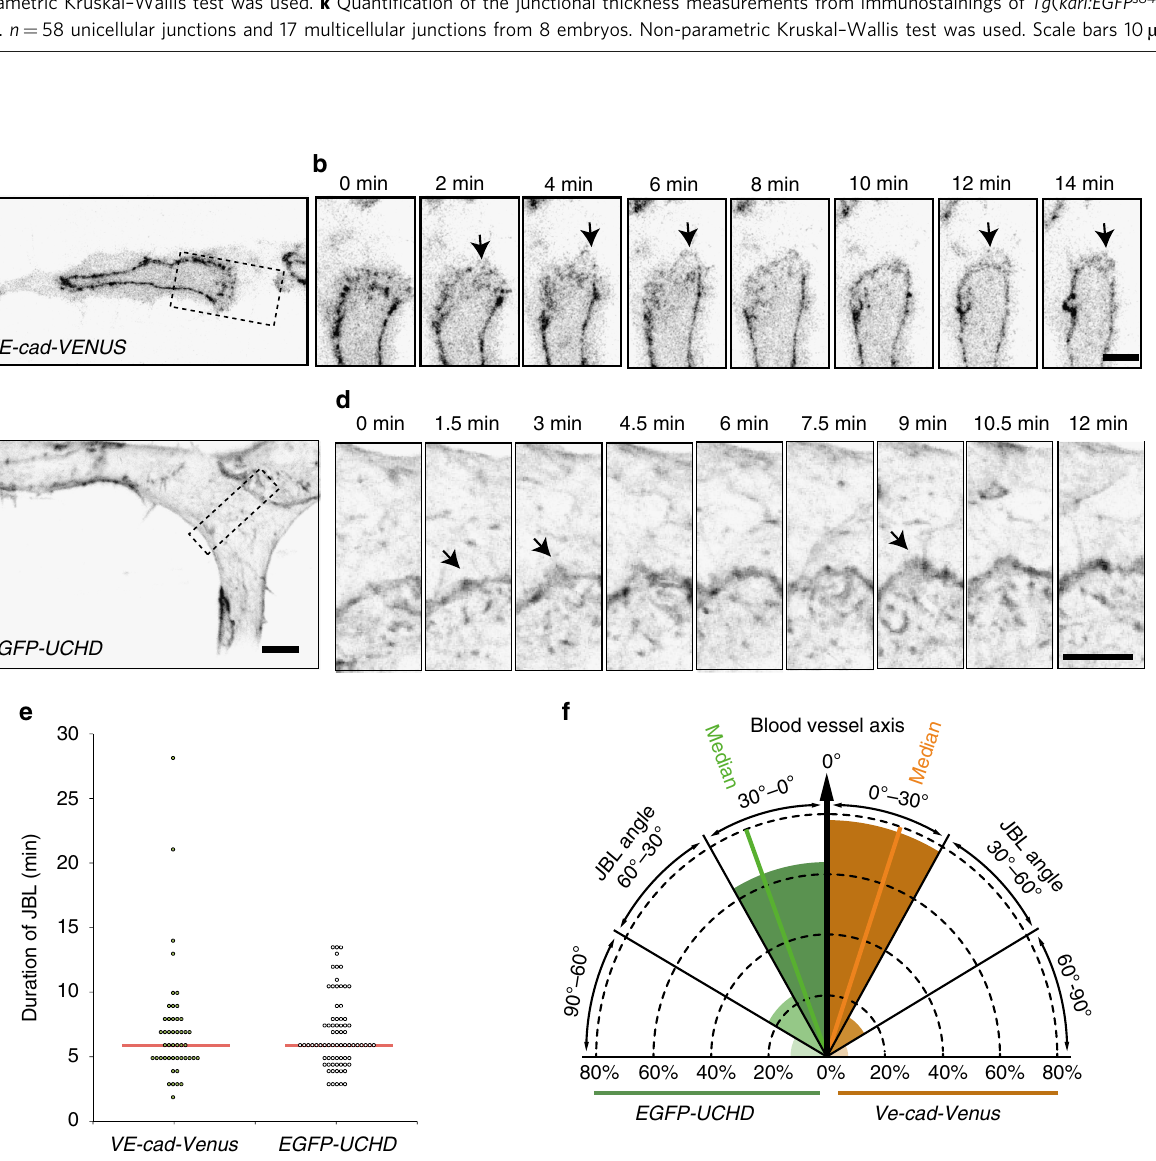
Fig. 1 Polarized thickness in remodeling junctions. a Schematic model of cellular rearrangements during formation and maturation of dorsal longitudinal anastomosing vessel (DLAV) in zebra fi sh. At fi rst, the tip cells (Cell A and B) of two anastomosing endothelial sprouts contact and form a de novo junction. Next, a vessel with unicellular architecture is formed, where junctions are not interconnected but are visible as separate rings. Then, through cellular rearrangement and elongation, the junctions elongate along vessel axis until junctions are interconnected and vessel reaches the fi nal multicellular architecture. The edges of the junctional gaps in the unicellular vessels are marked with green and yellow triangles. b – e Still pictures of a time-lapse movie (Supplementary Movie 1) showing EC junctions of Tg (BAC( cdh5:cdh5-ts )) embryo, which expresses VE-cad-Venus fusion protein, during transition from unicellular to multicellular vessel during DLAV formation, in inversed contrast starting around 28 hpf. The edges of the junctional gaps in the unicellular vessels are marked with green and yellow triangles. f Close-up image of VE-cad-Venus embryos. The diffuse thickening of medial domain of the junction is marked with a yellow arrow. g – i Whole-mount immuno fl uorescence staining of the DLAV using anti-ZO1, anti-VE-cad (rat) of 28 – 30 hpf ( Tg ( kdrl: EGFP s843 )) embryos. h The yellow arrow points to the medial junctional domain and the green arrow to the lateral junctional domain. j Quanti fi cation of junctional thickness measurements. n = 44 unicellular junctions and 48 multicellular junctions from 5 VE-cad-Venus Tg (BAC( cdh5:cdh5-ts )) embryos. Non-parametric Kruskal – Wallis test was used. k Quanti fi cation of the junctional thickness measurements from immunostainings of Tg ( kdrl:EGFP s843 ) embryos. n = 58 unicellular junctions and 17 multicellular junctions from 8 embryos. Non-parametric Kruskal – Wallis test was used. Scale bars 10 µ m